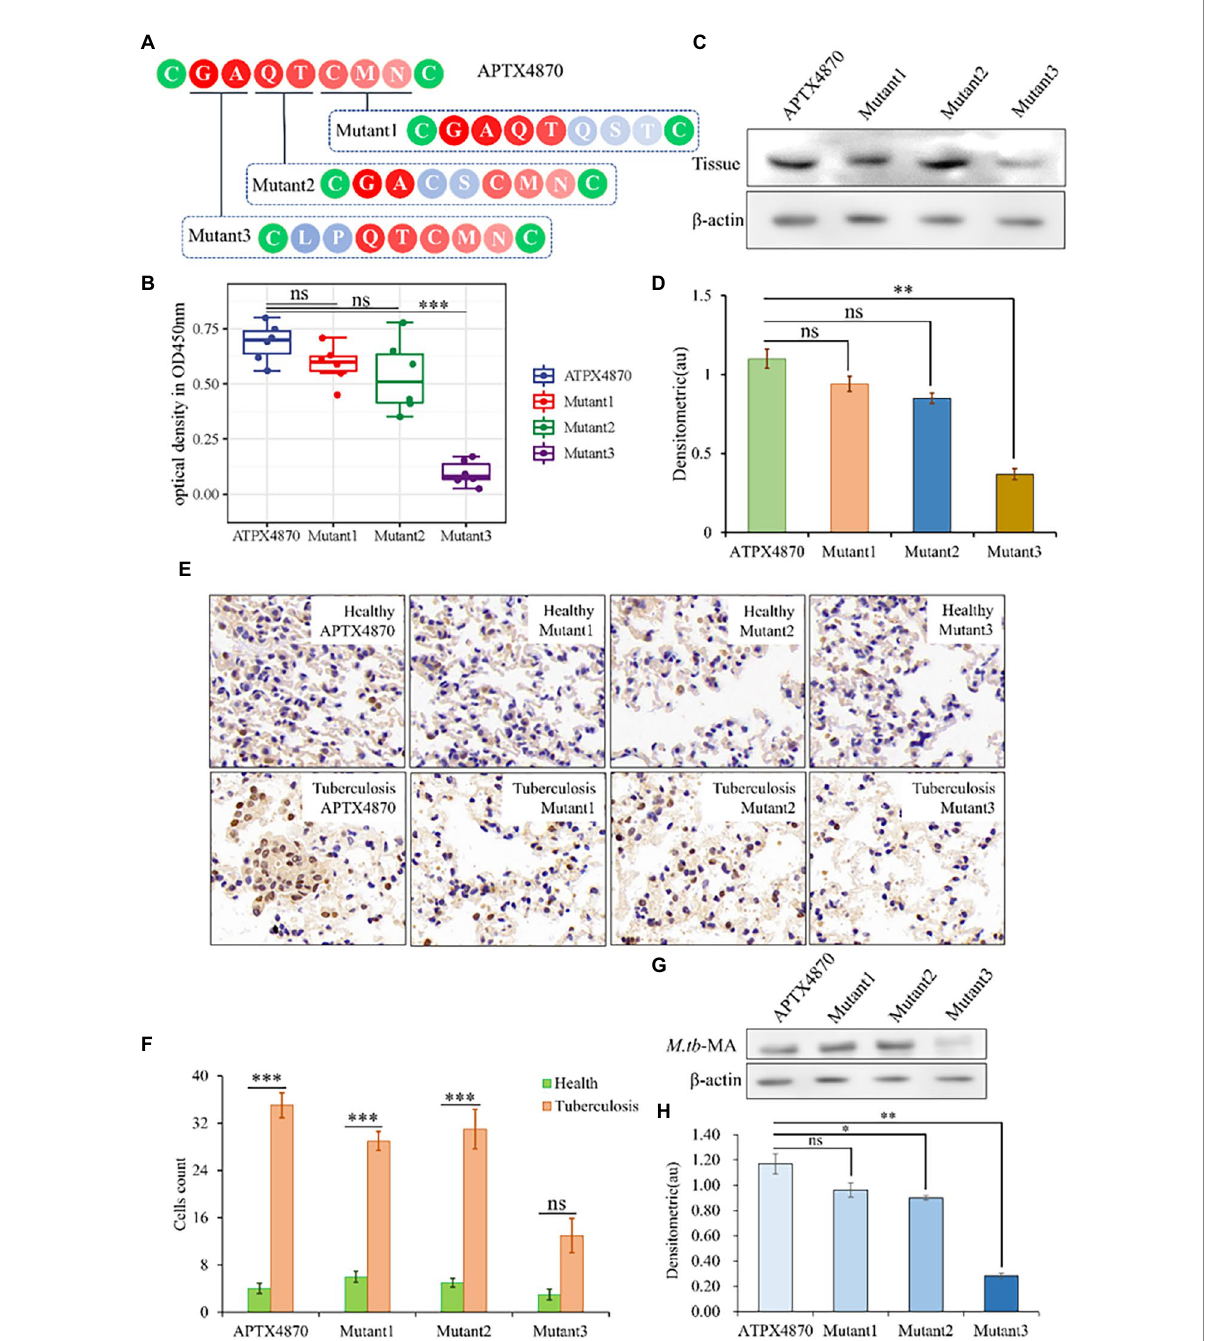
FIGURE 2 Identification of the active sites of M.tb -MA specific binding peptide. (A) Schematic diagram of APTX4870 amino acid mutations. (B) The binding of different His-mutants to patients lung tissue was tested via ELISA. The supernatant was coated on an ELISA plate for antibody sandwich detection. Custom antibodies were designed against APTX4870 (1:1000), Mutant1 (1:1000), Mutant2 (1:1000), and Mutant3 (1:1000) using Custom Polyclonal Antibody ( n = 6). (C) The binding ability of different mutants to the lung tissue of tuberculosis patients was detected by WB ( n = 3). (D) Semi- quantitative expression of indicated proteins by optical densitometry assay using ImageJ Software version 1.46. Data were presented as mean ± SD, ** : 0.01 < p < 0.05: Mutant3 vs. APTX4870 ( n = 3). (E) The binding ability of different mutants to the lung tissue of tuberculosis patients was detected by IHC. Scale bar = 50 μ m, n = 6 per group. (F) Quantitative the expression of binding sites by optical densitometry assay using ImageJ Software version 1.46. (G,H) Detection of binding of mutant polypeptides to M.TB-MA in cells. n = 3 per group. Quantitative the expression of binding sites by optical densitometry assay using ImageJ Software version 1.46. The data were shown as means ± SD and compared by a 2-way ANOVA test. * p < 0.05; *** p < 0.01: Tuberculosis vs.